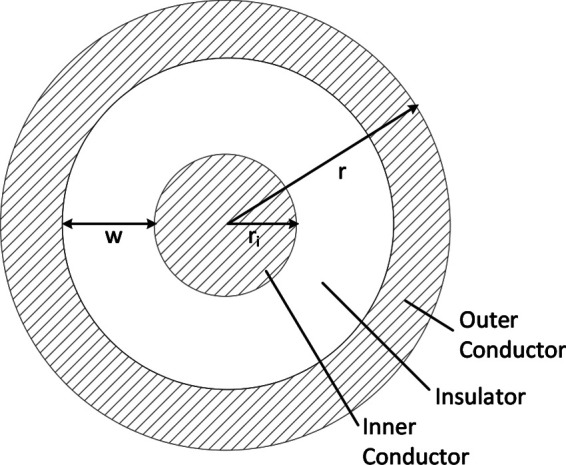
Coaxial wire model.